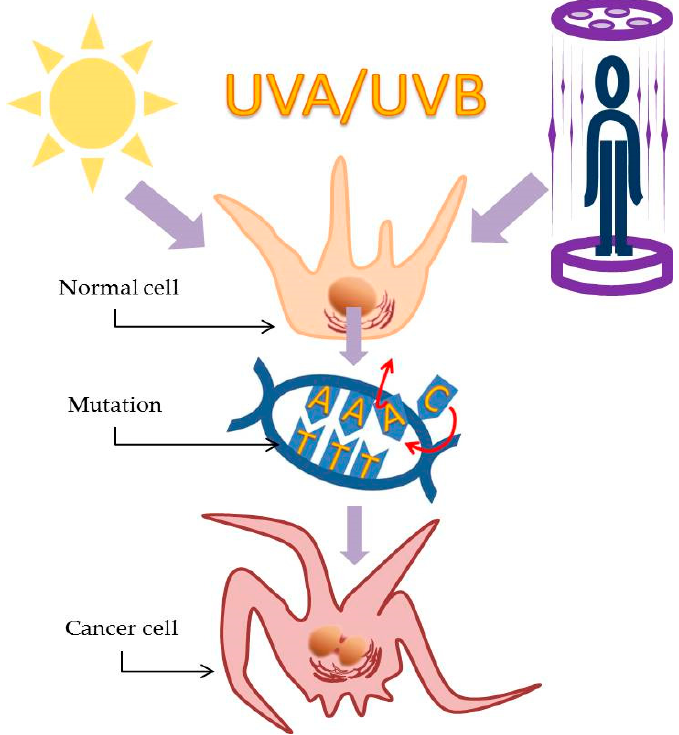
Figure 3. The e ff ect of UV radiation on skin Figure 3. The effect of UV radiation on skin cells.